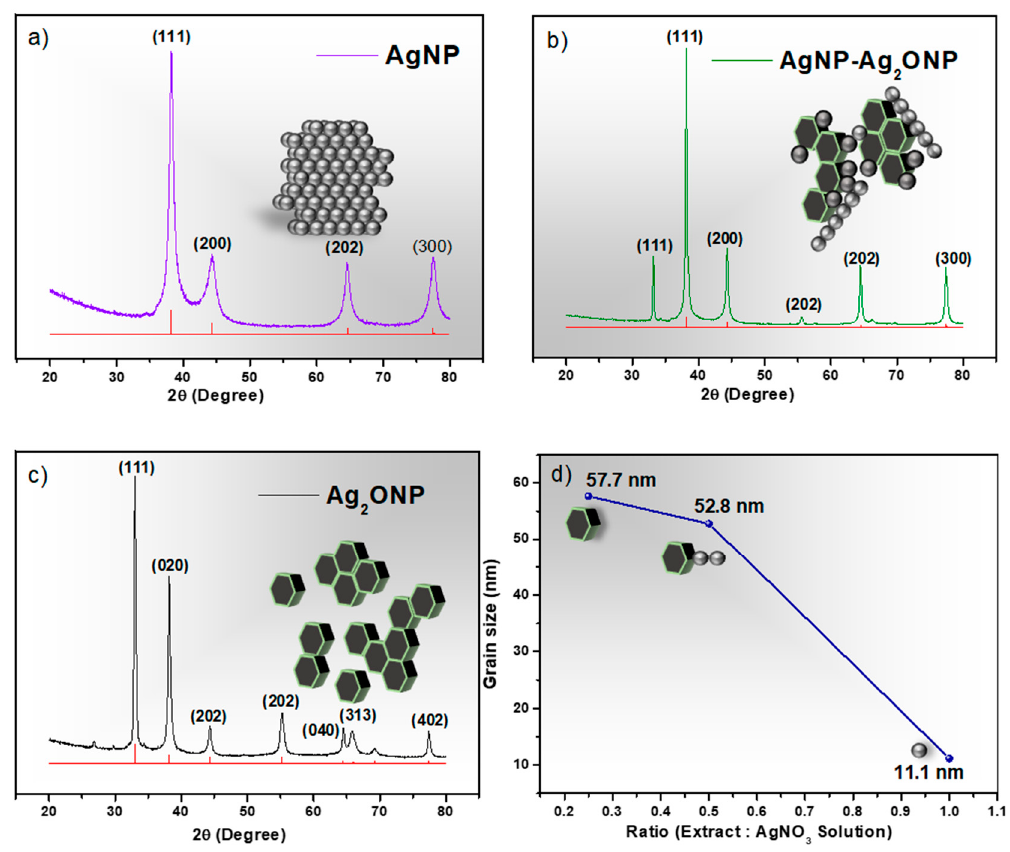
Figure 1. X-ray diffraction (XRD) patterns of synthesized nanoparticles at different extract ratios: ( a ) AgNP at 1:1 ratio; ( b ) AgNP–Ag 2 ONP at 1:2 ratio; ( c ) Ag 2 ONP at 1:4 ratio; ( d ) grain size vs. extract ratio of synthesized nanoparticles.